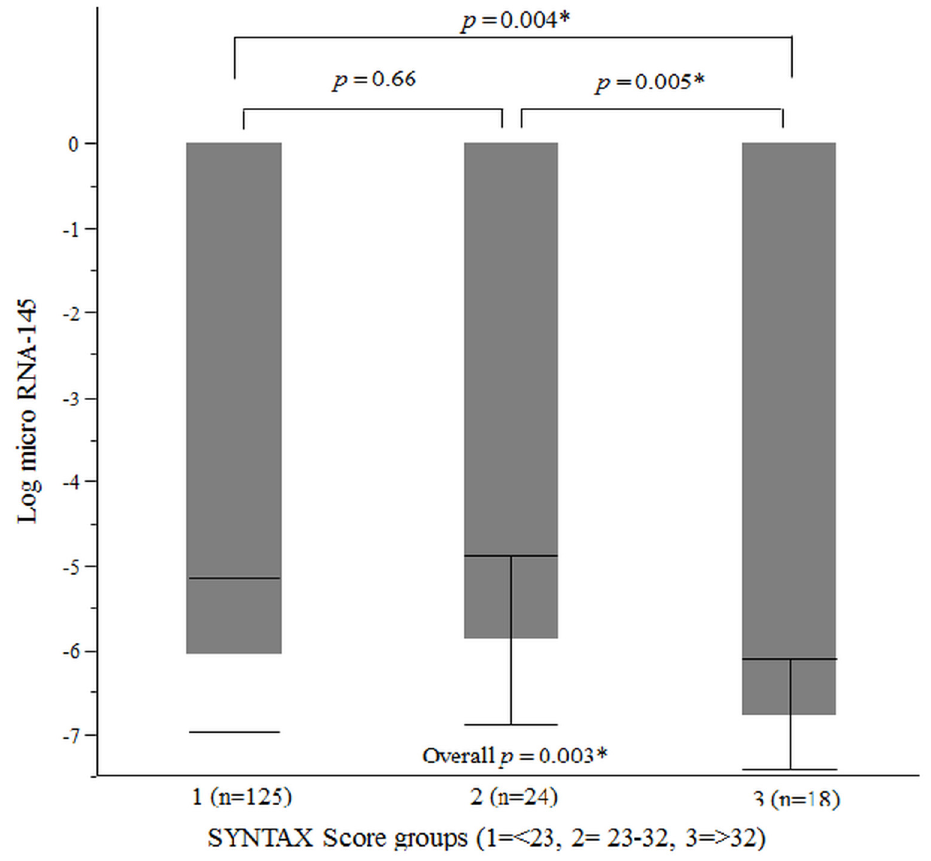
Fig 2. SYNTAX groups and plasma miRNA-145. These bars represent averages of plasma miRNA-145 levels across SYNTAX groups. T-bars indicate standard deviation. It can be noted that patients with high risk SYNTAX scores had significantly lower Ln_miRNA-145 compared with low and moderate risk groups. * p < 0.05; RNA, Ribonucleic acid; SYNTAX, Synergy Between PCI With Taxus and Cardiac